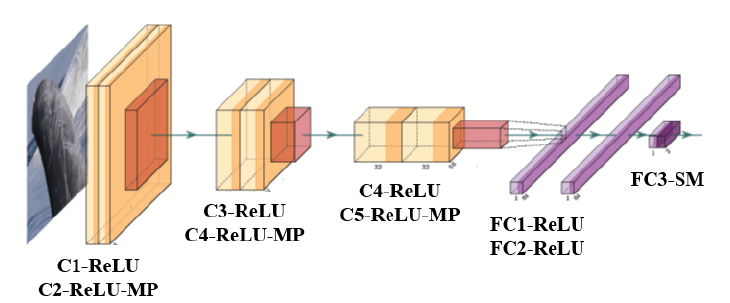
Figure 6. CNN architecture and processing stages of a single image. The yellow-orange blocks represent the convolution and pooling layers, while the purple blocks represent the final classification layers. C is used for Convolutional Layers, ReLU for Rectified Linear Units, MP for Max Pooling, FC for Fully Connected Layers and SM for